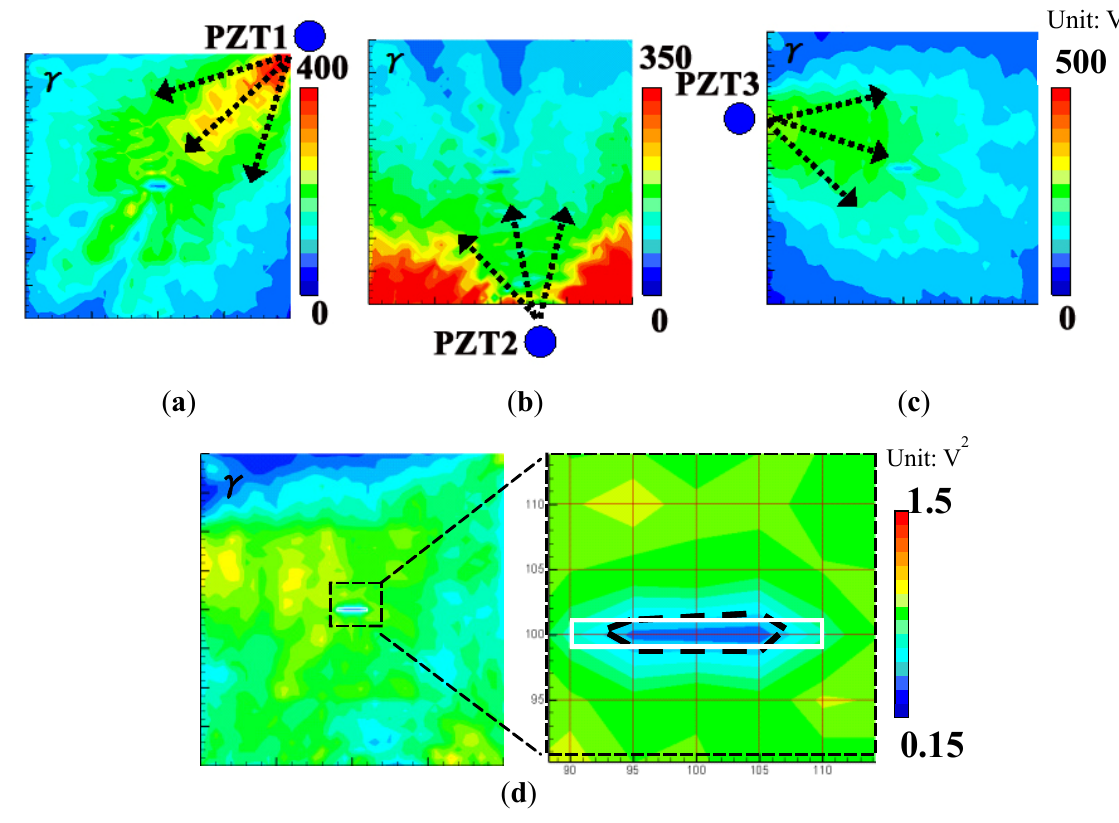
non-penetrating slit (irradiated side with slit): ( a ) PZT-1; ( b ) PZT-2; ( c ) PZT-3; ( d ) PZT-(1 + 2 + 3).